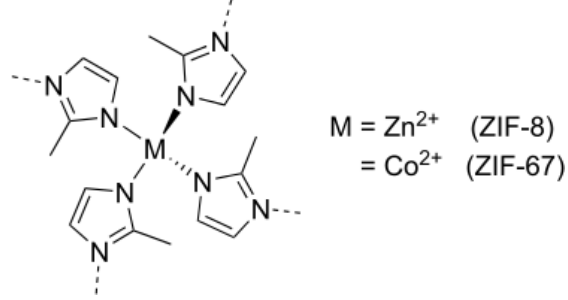
Figure 8. Structure of probed MOFs, i.e., ZIF-8 and ZIF-67. Table 5. 13 C NMR reference spectra of ZIFs recorded on a Bruker Avance III spectrometer (400MHz 1 H frequency; solid-state NMR). The chemical shifts are given in